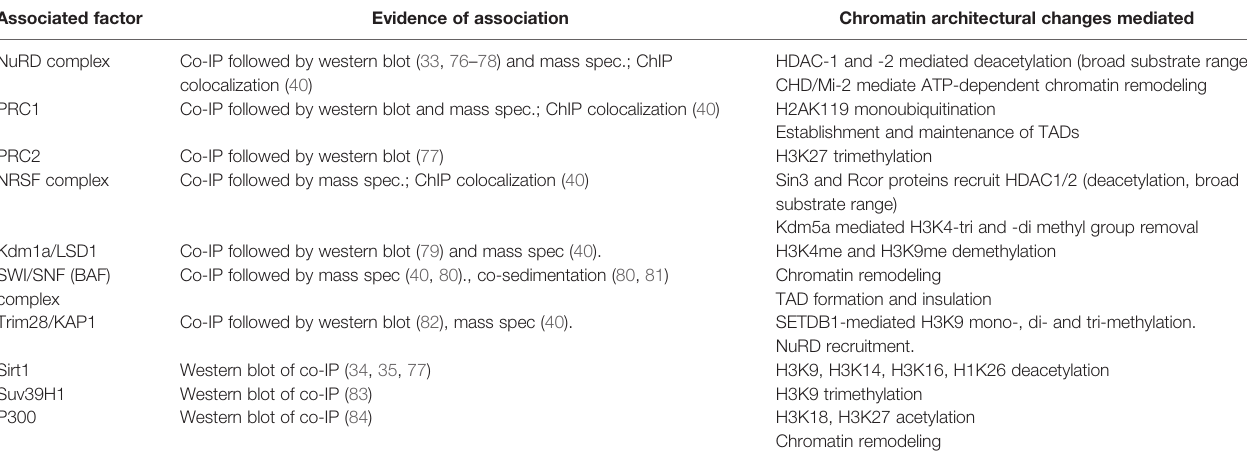
TABLE 1 | Chromatin modifying activities of Bcl11b co-bound